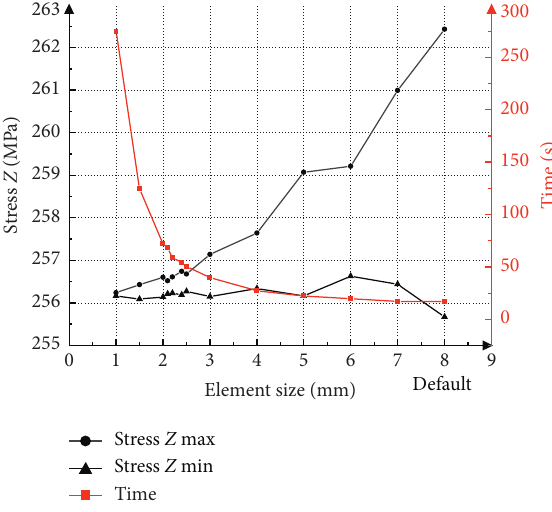
Figure 9: Mesh sensitivity analysis diagram.